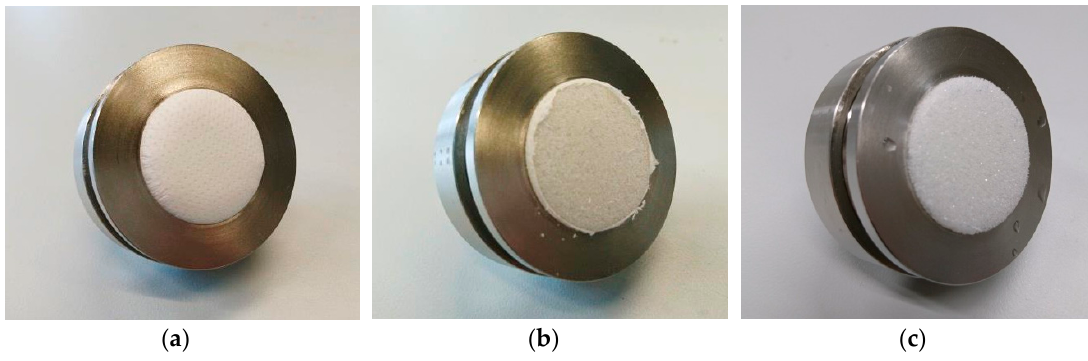
Figure 8. Electrospun nanofiber mat in Martindale abrasion test holder, ( a ) before the test, ( b ) after 10 cycles in dry state, and ( c ) after one cycle in wet state.